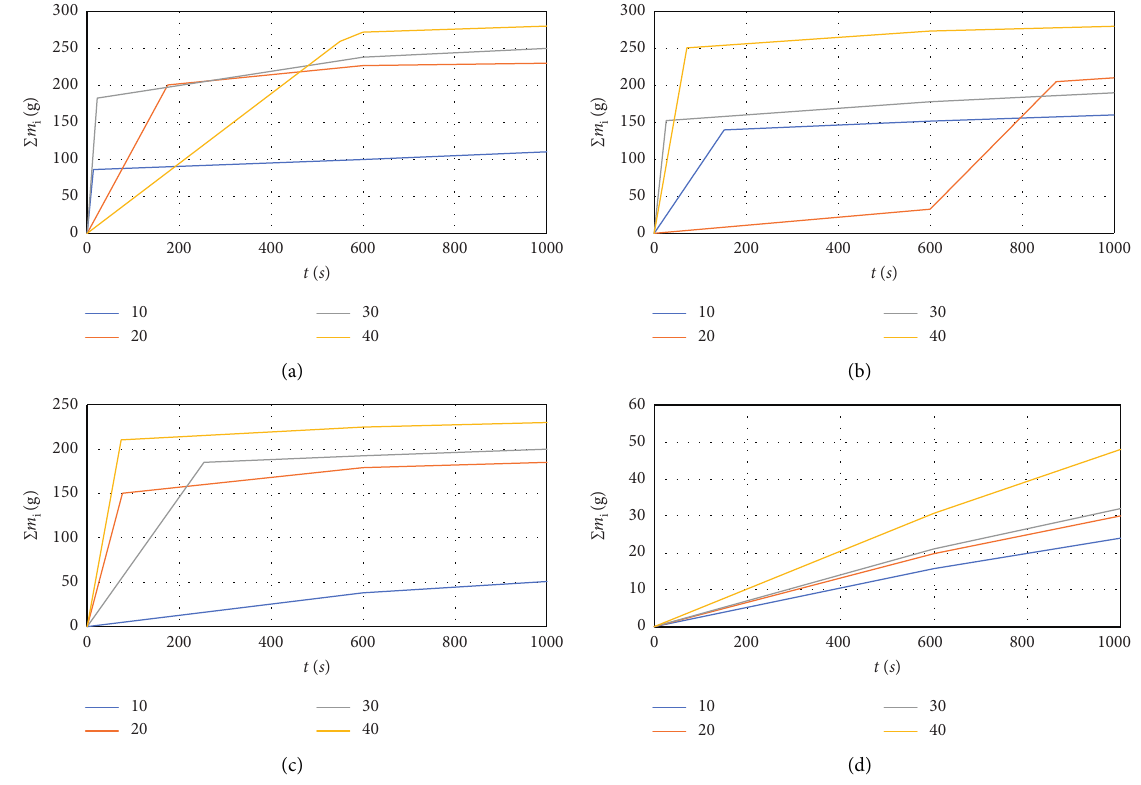
Figure 7: The mass loss of crushed stone aggregates with different gradation. (a) n � 0.4. (b) n � 0.5. (c) n � 0.6. (d) n � 0.7. Table 3: The optimal gradation and compaction